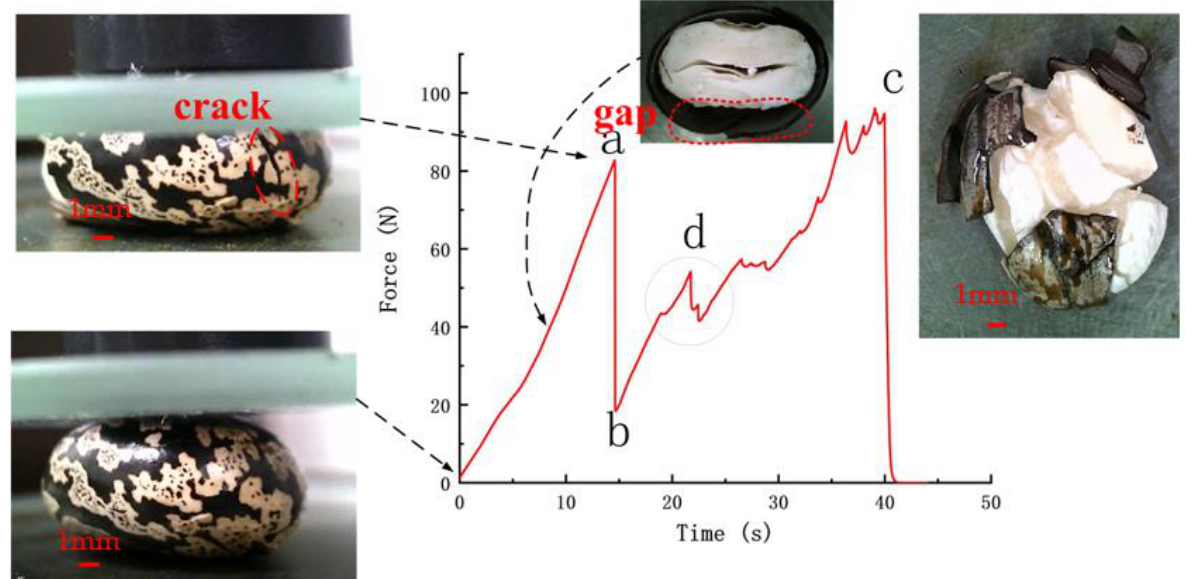
Figure 2. Force – time curve during extrusion. Figure 2. Force–time curve during